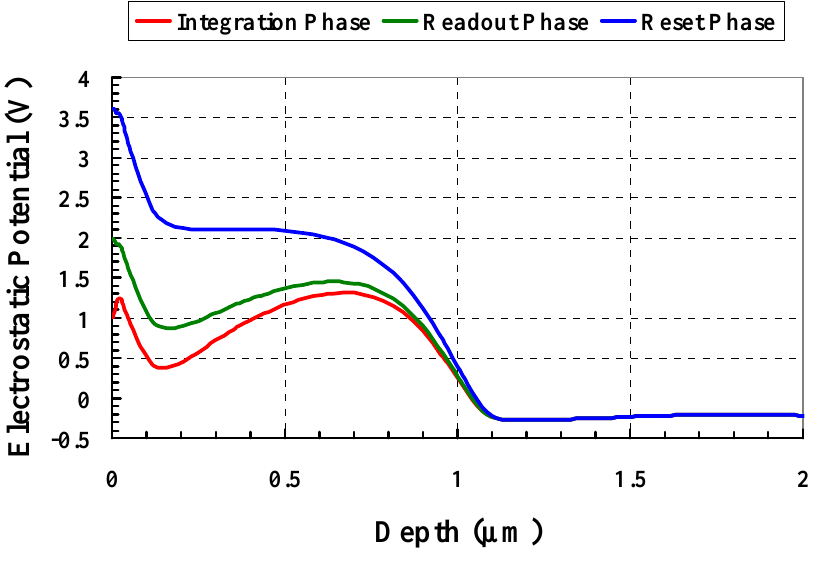
Figure 1. Potential profile of the transistor body.